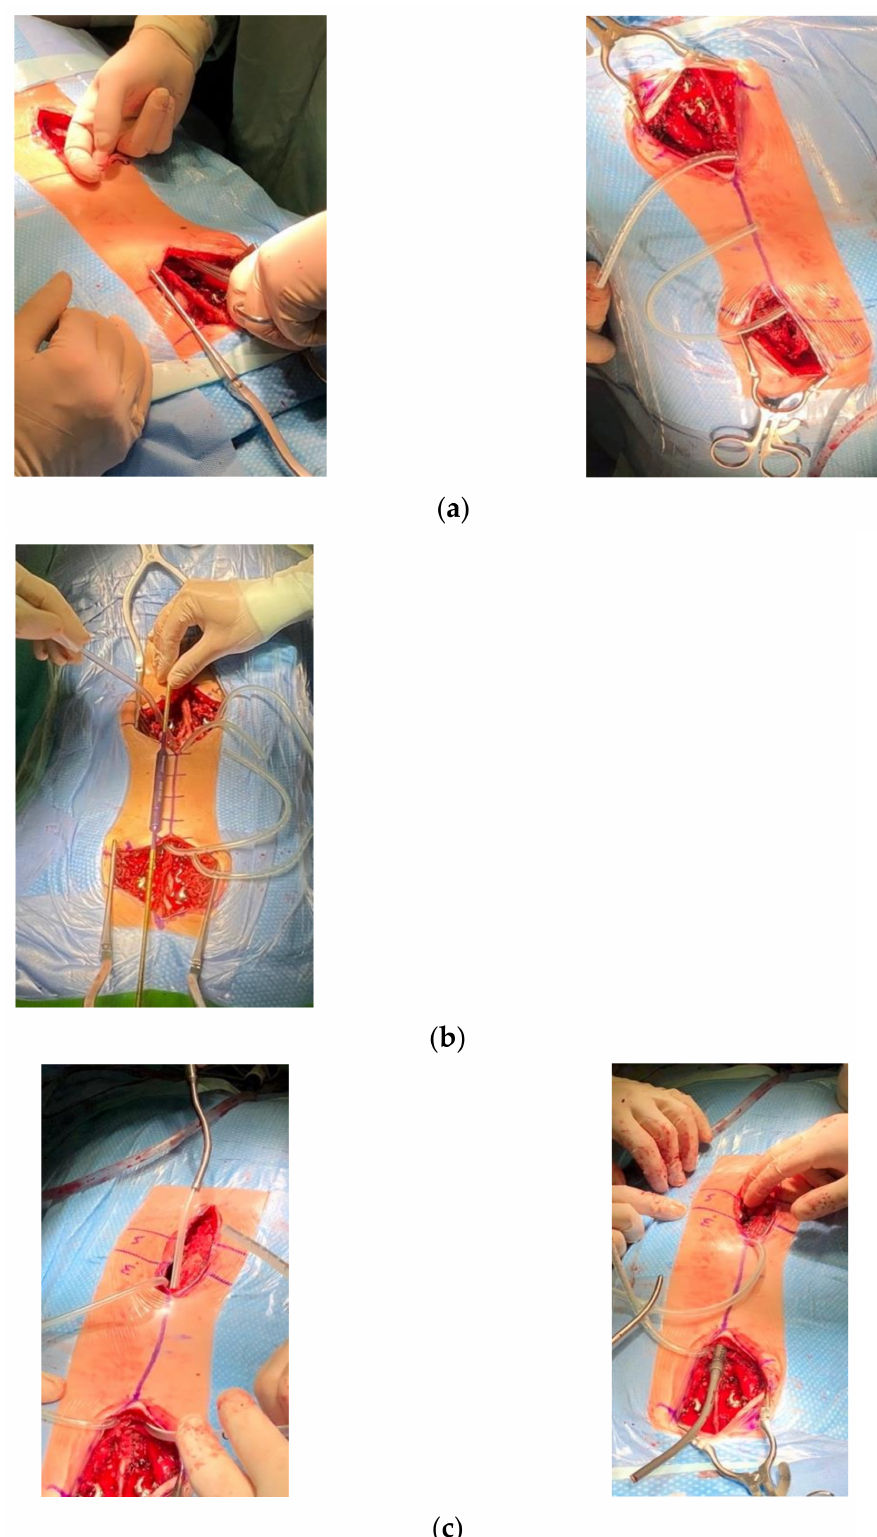
Figure 6. ( a ) Intraoperative pictures: using a paean, we created rod tunnels immediately under the fascia not reaching the spine. ( b ) Using drains as a guide for the insertion of temporary MCGRs. ( c ) Inserting MCGRs followed by